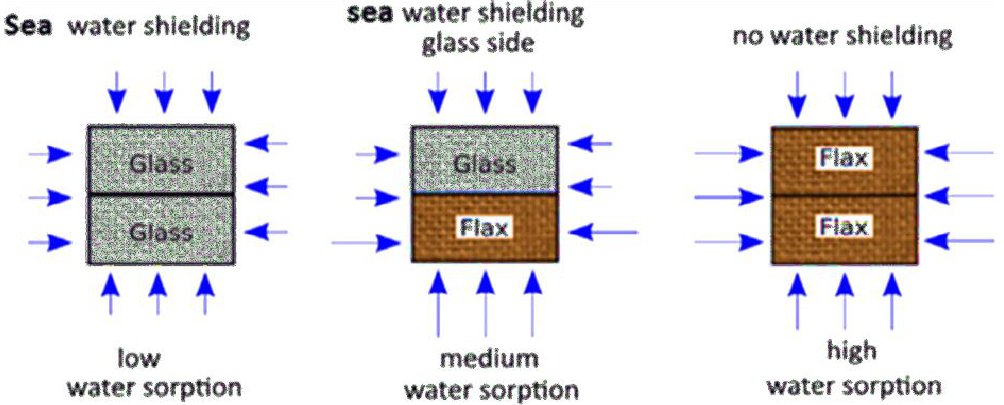
Figure 6. Water diffusion techniques on fibre-reinforced composite materials [88] (reprinted with permission from Elsevier, Licence Number: 5446951281414).